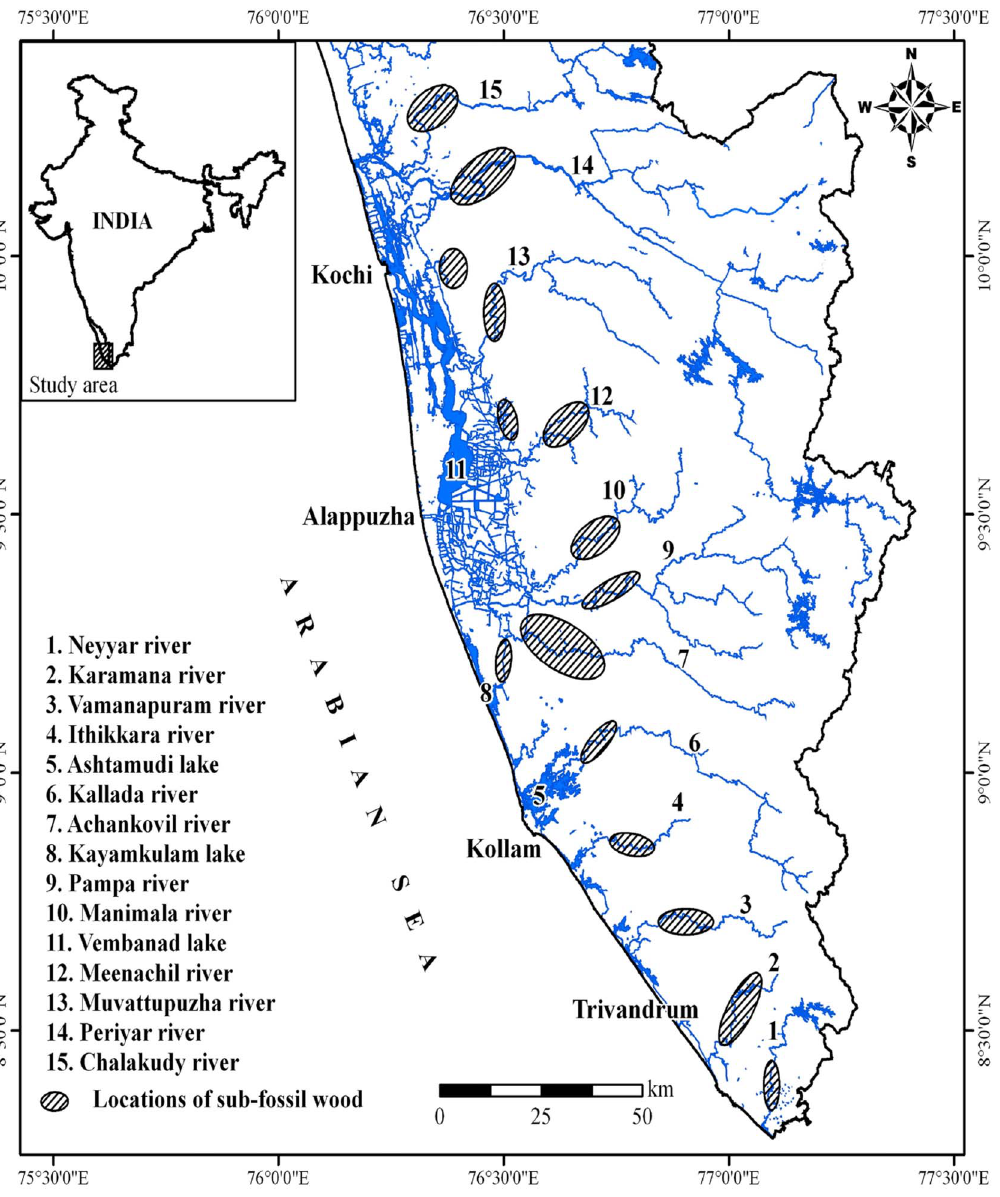
Figure 2. Landward extension of Kerala–Konkan basin showing fossil wood locations associated with wetlands and major river basins of south west